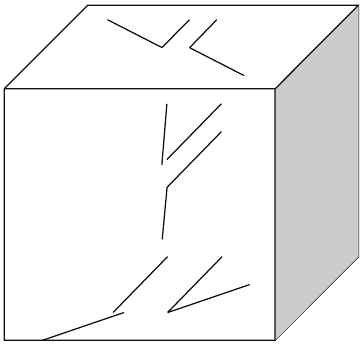
Figure 1: The draft of the sensing